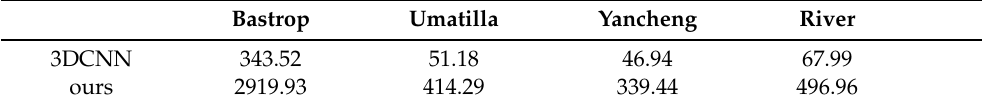
Table 5. Time cost (seconds) of each dataset.